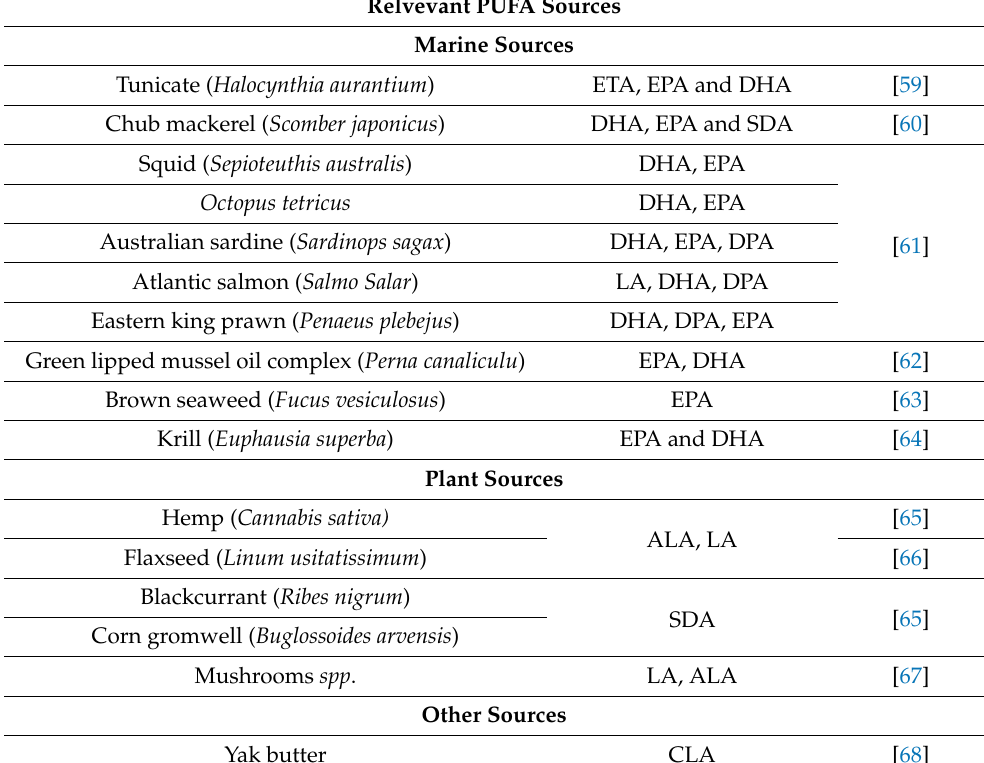
Table 2. Dietary sources of